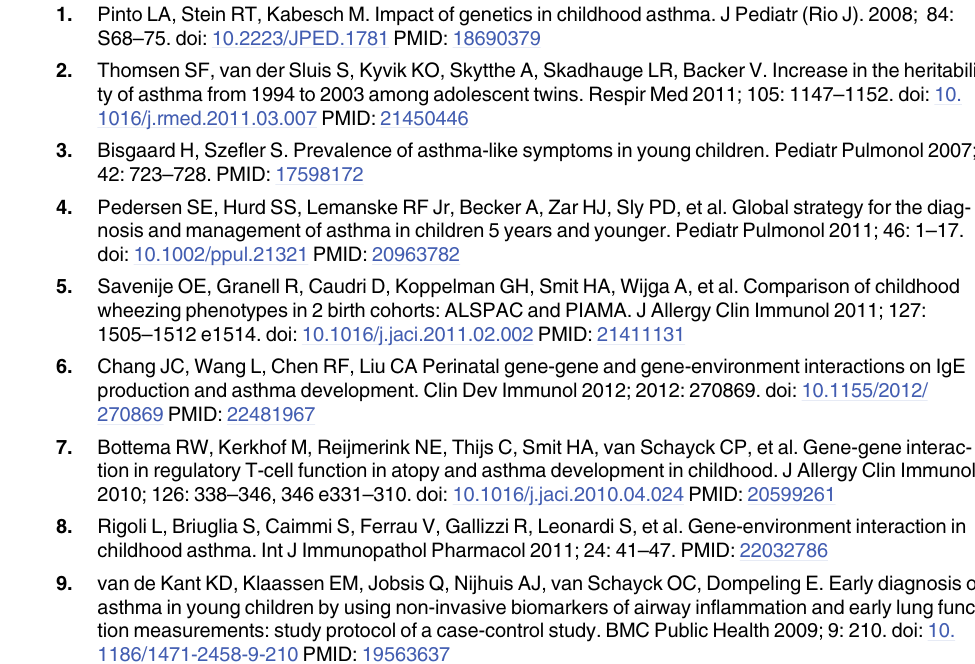
S4 Table. Results of analysis for genetic variants in the ADEM study. a Adjusted for sex and exposure to parental smoking and furry pets. Abbreviations: 95% CI: 95% Confidence Interval; A: Asthma; n: number of children; OR: Odds Ratio; p: p-value; TW: Transient